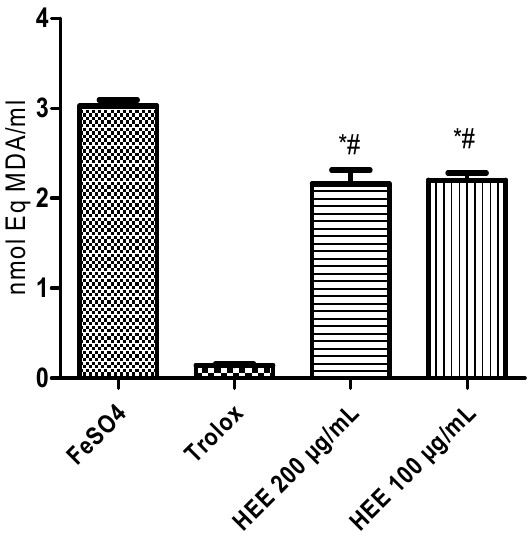
Figure 3. Inhibitory capacity of lipid peroxidation measured by the generation of malondialdehyde (MDA) induced by ferrous sulfate. * Different from the negative control ( p < 0.001); # Different from the positive control trolox ( p < 0.0001).